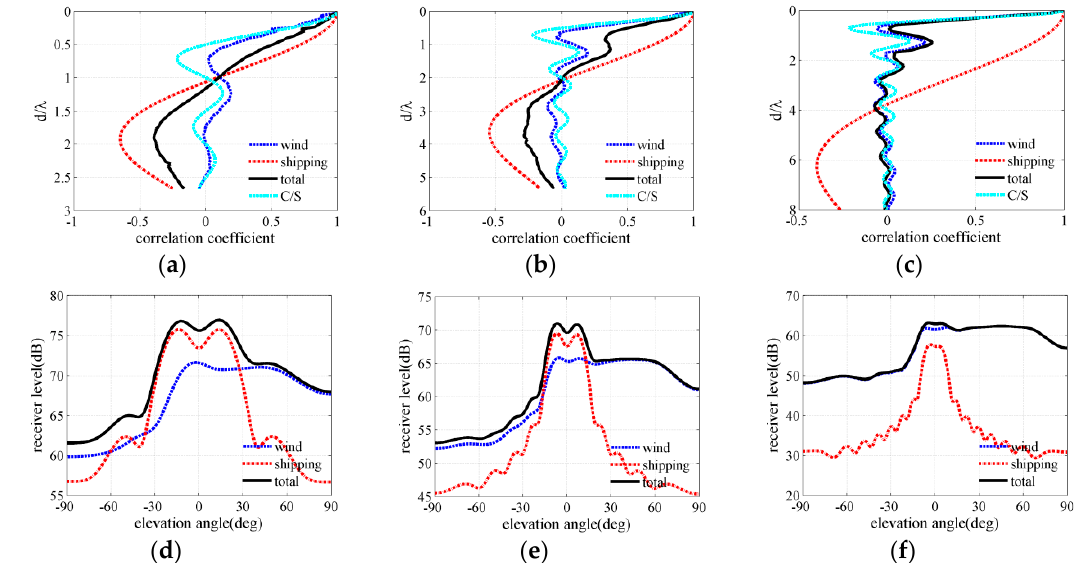
Figure 6. Vertical correlation and directionality at wind speed of 12 m/s for frequencies of ( a , d ) 50 Hz